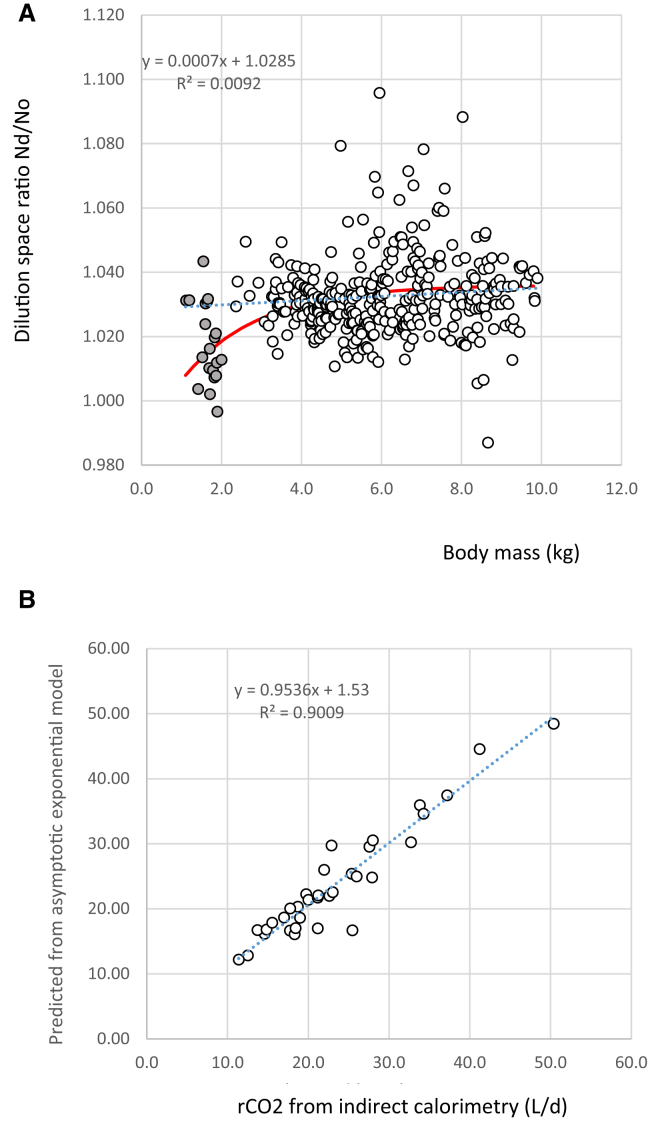
Dilution space ratio as a function of body mass and performance of new equation against indirect calorimetry(A) Dilution space ratios (the hydrogen dilution space Nd divided by the oxygen dilution space No) of 332 babies weighing <10 kg from the IAEA DLW database v 3.1 (open circles) combined with data from validation studies in preterm and full-term babies (gray circles). For the sample from the database, there was a linear relationship (blue dotted line that marginally failed to reach significance p = 0.08). We fitted an asymptotic exponential to the combined dataset (red line; r2 = 6.4%; p < 0.03).(B) The results of validation studies of the DLW method in babies comparing the DLW estimates of CO2 production (rCO2) derived from a combination of Equations 9 and 10 presented here and rCO2 measured by indirect calorimetry. There was a strong linear relationship fitted by least-squares regression—dotted blue line, with r2 = 0.90.